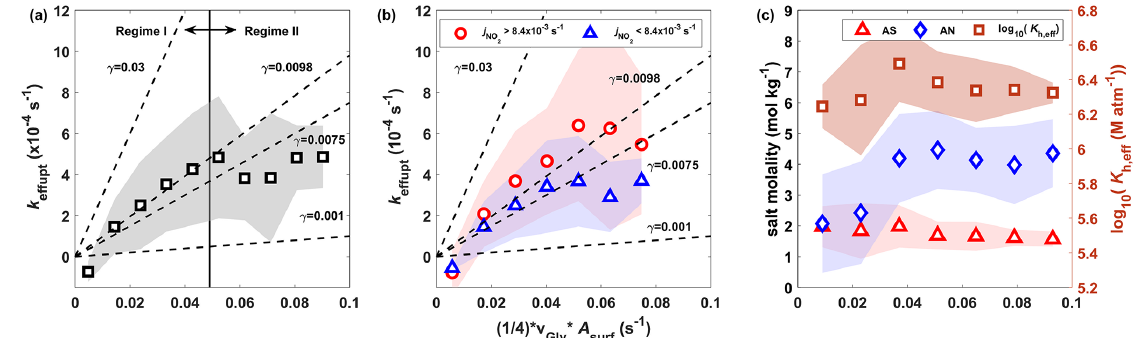
than median conditions (8 . 6 × 2